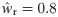
Spike-frequency adaptation enables frequency-selective amplification and preserves co-activity.(A) Frequency response analysis of the interneuron network with recurrent connections among both SOM and VIP neurons. Increasing recurrence reduces the frequency-resolved amplification index across all stimulation frequencies. (B) Same as in (A), but with spike-frequency adaptation instead of recurrence. The circuit yields a maximal response at a resonance frequency. With increasing adaptation strength, this resonance frequency increases. (C) The frequency-resolved amplification index decreases with increasing adaptation strength for low-frequency oscillations, but increases for high-frequency oscillations (frequency-selective amplification, cf. markers in (B)). (D) Neurons show stronger correlations (positive or negative) with spike-frequency adaptation (left, upper panel) than with recurrent inhibition among SOM and VIP neurons (left, lower panel). Mean SOM-SOM neuron correlation is more sensitive to increasing recurrence strength than to adaptation strength (right). (E) While strengthening mutual inhibition leads to an increase of the maximal frequency-resolved measure of amplification, it does not change the resonance frequency (top, adaptation strength b = 0.8). In contrast, increasing the adaptation strength allows to adjust the resonance frequency, with a weak impact on the maximum of the frequency-resolved amplification index (bottom, recurrence strength w^r=0.8). (F) Schematic representation of both separate “knobs” (mutual inhibition and adaptation) and their independent control of the amount and frequency-selectivity of the amplification. Parameter (A-E): Mutual inhibition strength w^=0.8.